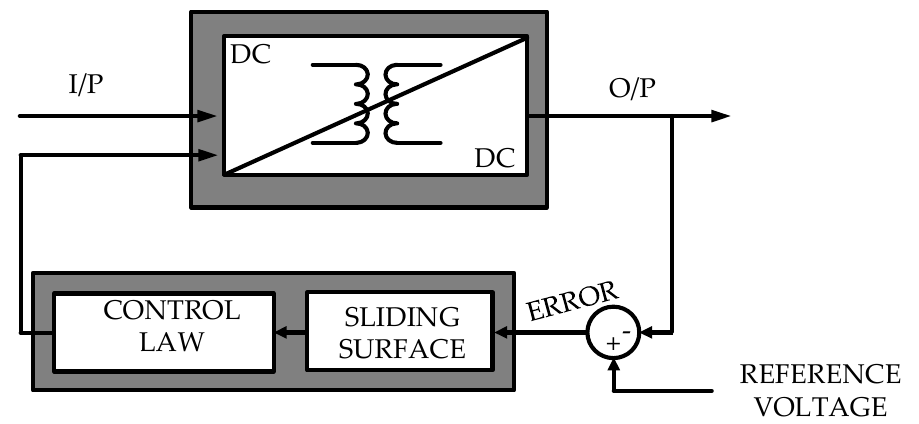
Figure 9. Representation of sliding mode control.